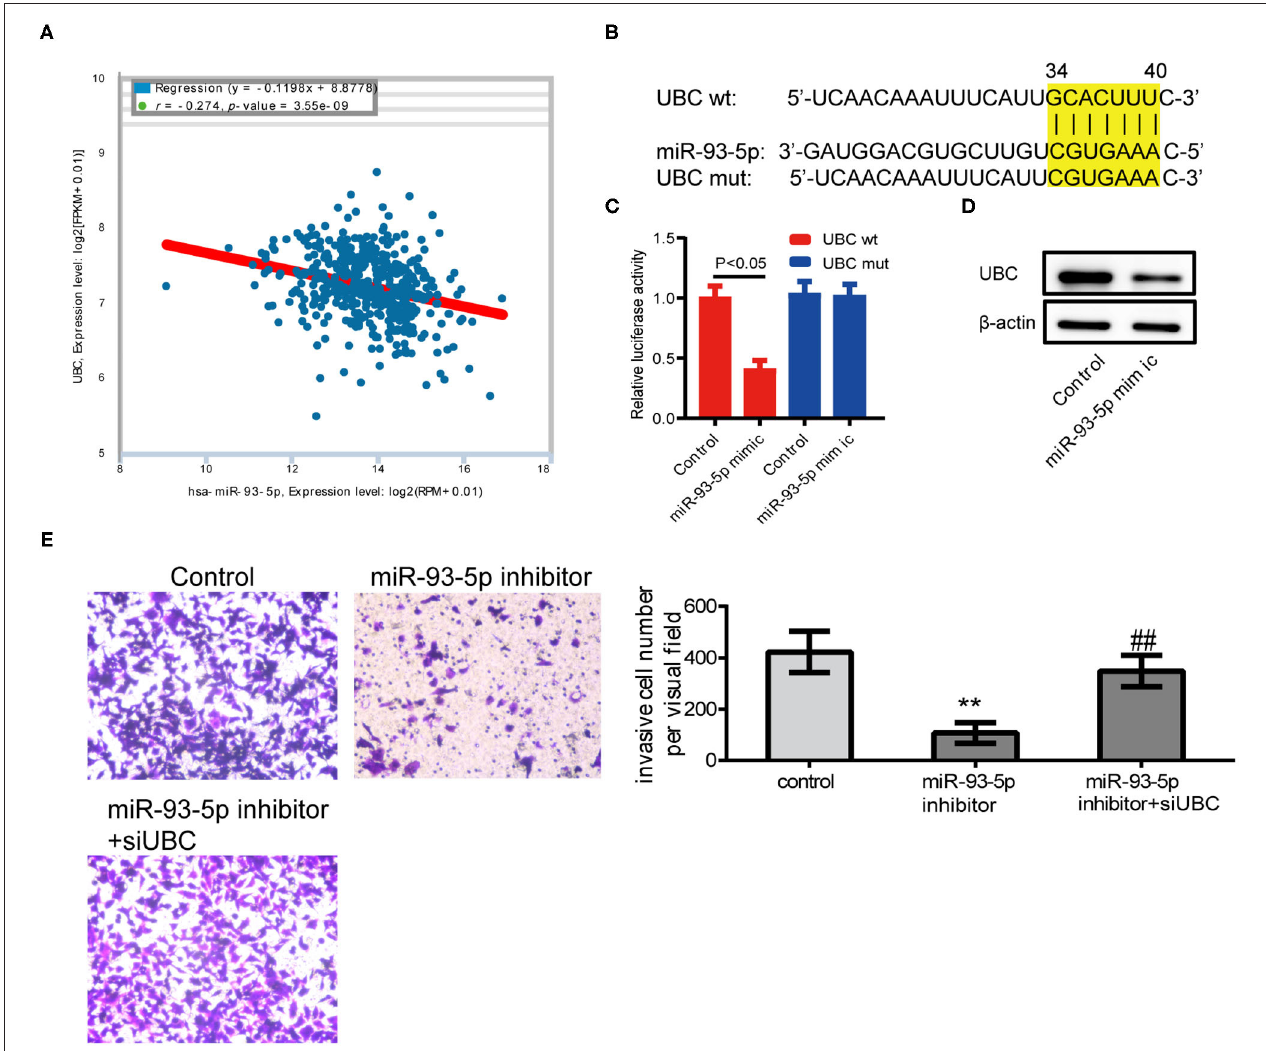
FIGURE 5 | Inhibition of miR-93-5p could reduce SK-MEL-28 cells’ invasive ability through UBC. (A) The miR-93-5p and UBC expression data of 449 melanoma patients from ENCORI. We observed the inverse correlation with statistical significance between miR-93-5p and UBC mRNA. (B) Diagram of UBC 3’UTR including 1 putative conserved target sites for miR-93-5p, recognized through making use of the TargetScan database. (C) Results of luciferase reporter experiments in SK-MEL-28 cells, with co-transfection of wt or mt 3’UTR and miR mimic, as shown. (D) The protein expression of UBC in SK-MEL-28 cells transfected with